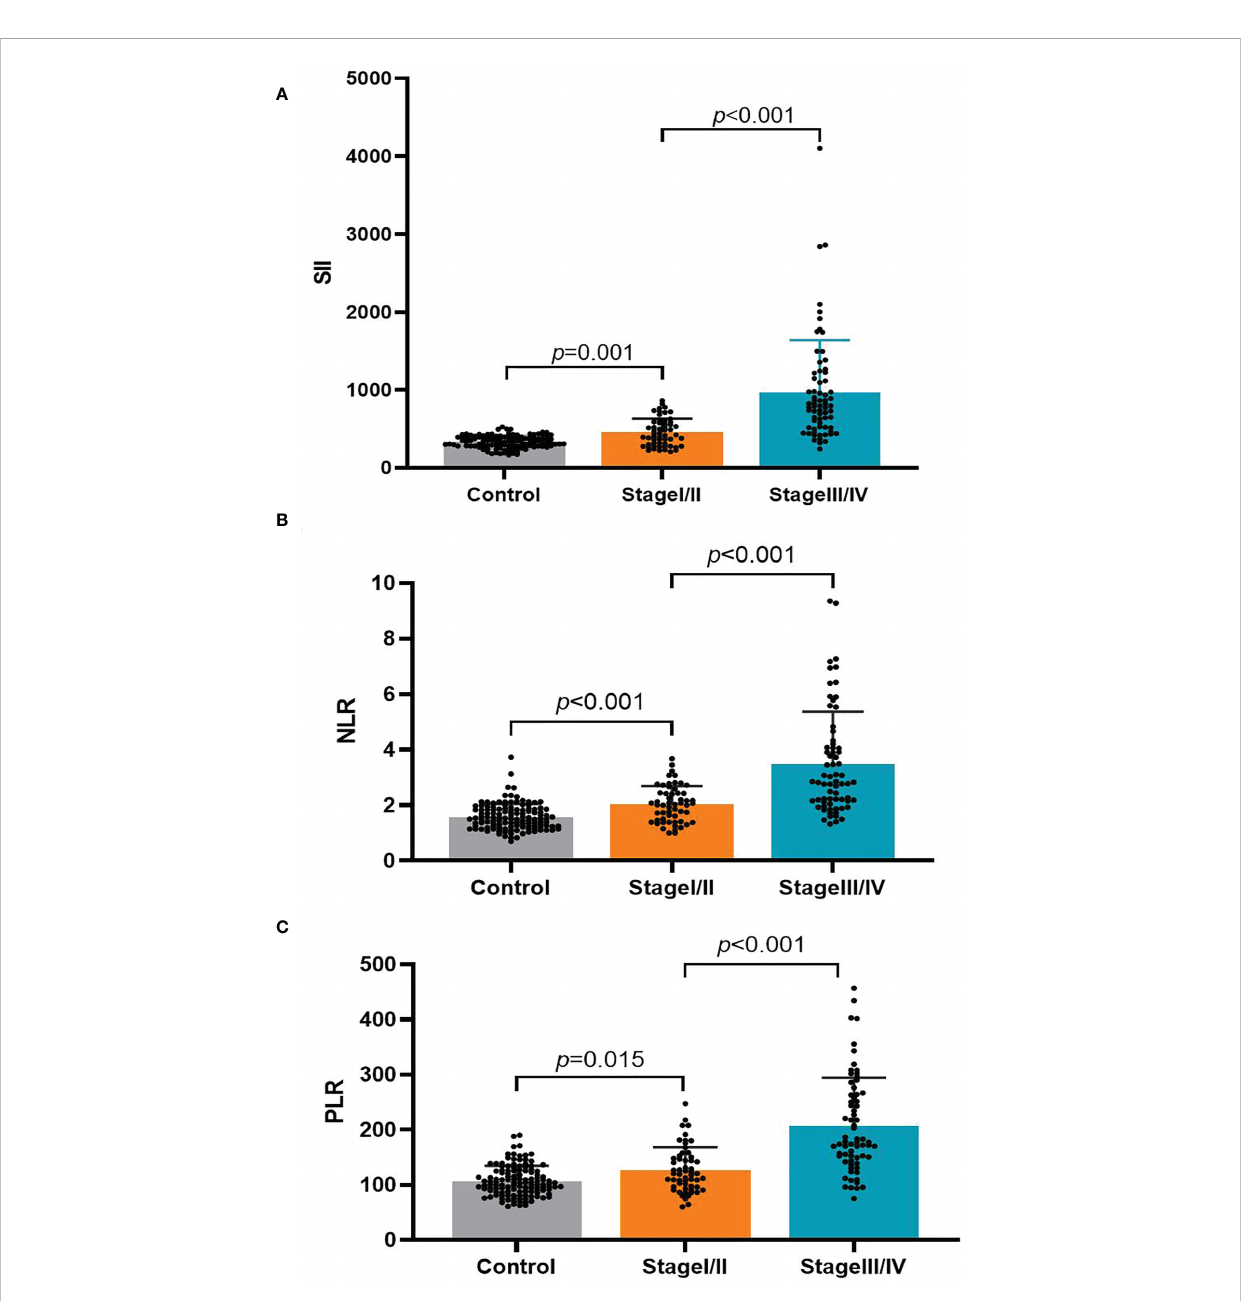
FIGURE 2 The association of the platelet-lymphocyte ratio (PLR), neutrophil-lymphocyte ratio (NLR), and systemic immune-in fl ammation index (SII) with the TNM stage in gastric cancer patients. (A) SII; (B) NLR; (C)